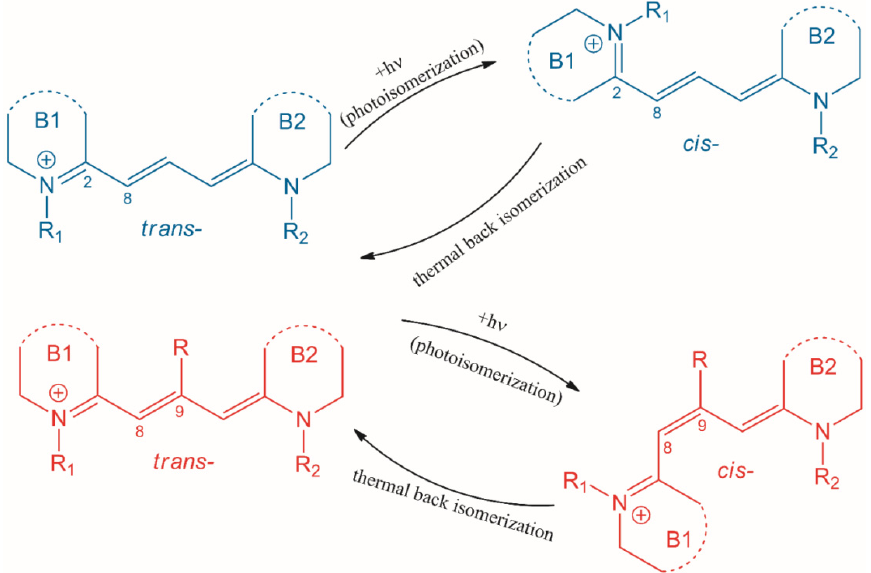
Figure 2. Generalized scheme of trans – cis photoisomerization and thermal back isomerization of unsubstituted (blue) and meso ‐ substituted (red) trimethine cyanine dyes. Cyanine dyes are characterized by an equilibrium between the trans ‐ and cis ‐ isomers [17,18]. In the case of cyanine dyes that do not have substituents in the polymethine chain,